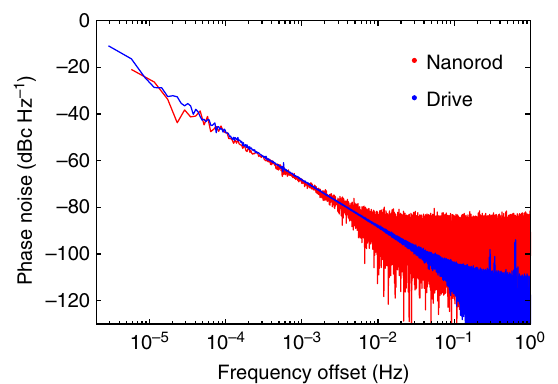
Fig. 2 Characterizing the locked rotation. The phase noise of the rotor (red) and drive (blue) is calculated from two individual four day measurements at a drive frequency of f d = 1.11 MHz (see “ Methods